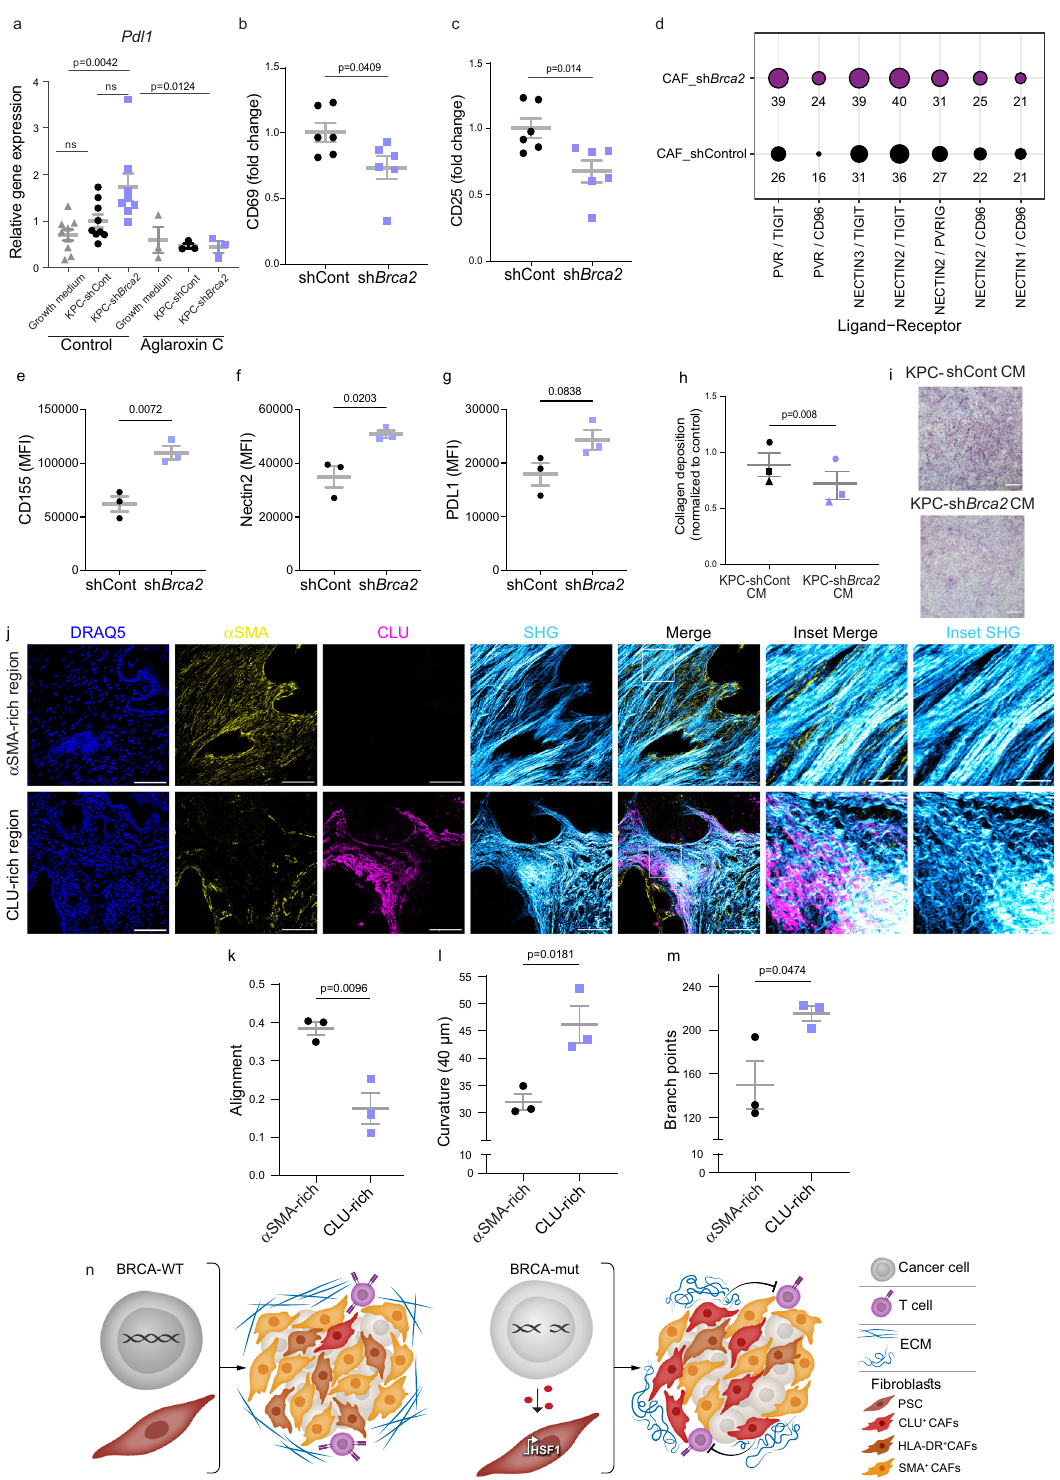
MxIF staining in BRCA- WT vs BRCA -mut patients (Fig. 6j – m). CLU-rich stromal regions that are abundant in BRCA -mut tumors demonstrated an altered ECM architecture, characterized by signi fi cantly reduced parallel alignment, and increased curvature and branching of collagen streaks compared to α SMA - rich regions (Fig. 6j –